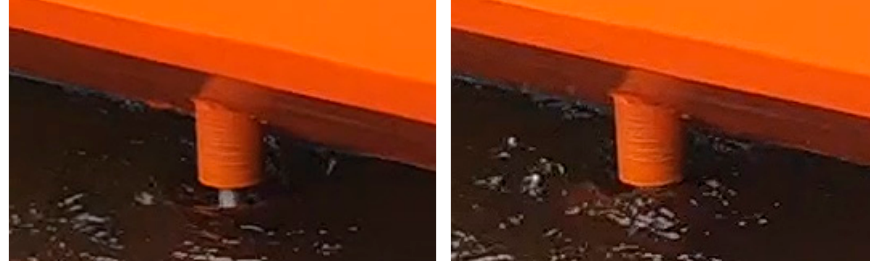
Figure 3. Water level changes around the rotating cylinder.